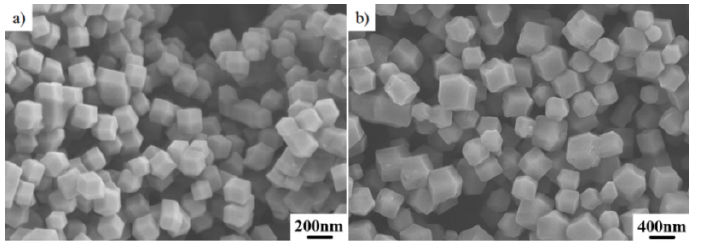
Figure 1. ( a ) The initial morphology of ZIF–8, ( b ) The initial morphology of